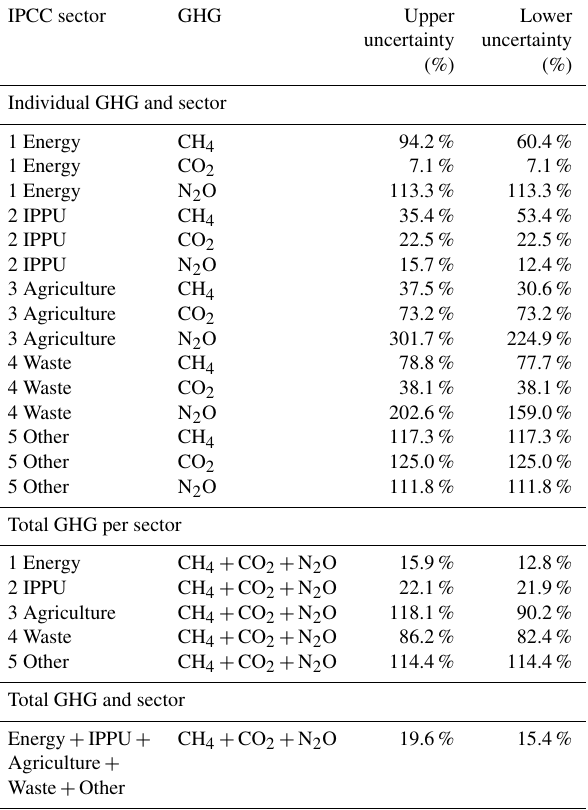
Table 6. Global uncertainty ranges defining the 95% confidence in- tervals of a log-normal distribution. IPPU stands for industrial pro- cesses and product use, and GHG stands for greenhouse